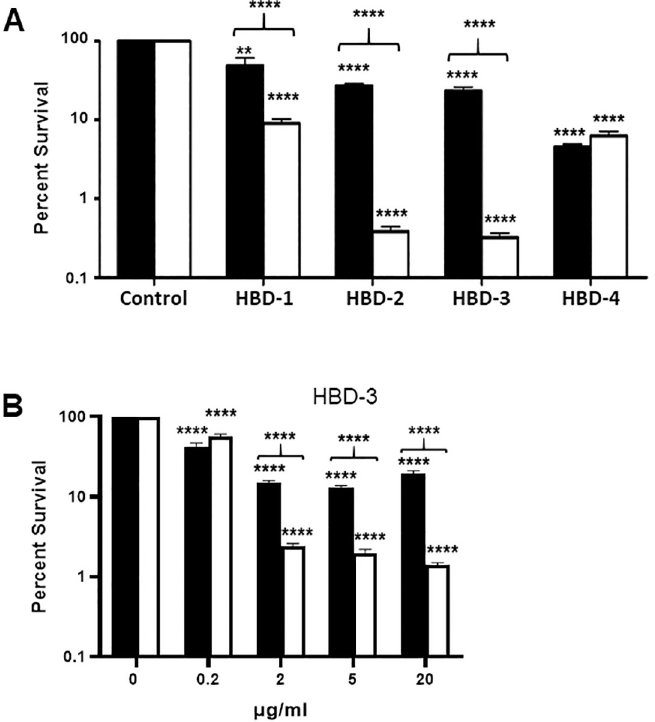
Fig 2. Human beta defensins have reduced bactericidal activity against an encapsulated B . anthracis strain compared to a non-encapsulated strain. Encapsulated WT and non-encapsulated capA mutant bacilli were incubated with human beta defensins 1, 2, 3, 4 (HBD-1, 2, 3, 4) at a final concentration of 20 μ g/ml (A) or with varying concentrations of HBD-3 (B) in triplicate tubes at 37˚C in 5% CO 2 for 2 h and plated for CFU. Control tubes without defensins were incubated and plated in parallel. Survival percentages were determined by calculating the ratio of CFU with/CFU without defensin. Three experiments were run (n = 3). Results expressed as the mean + SEM from a representative experiment are shown. Black bars represent WT and white bars represent capA mutant. Significance of killing was determined by ANOVA with Tukey’s post-hoc test. Significance of differences in survival between the WT and capA strains was determined by two-tailed Student’s t-test ( �� p < 0.001, ���� p <